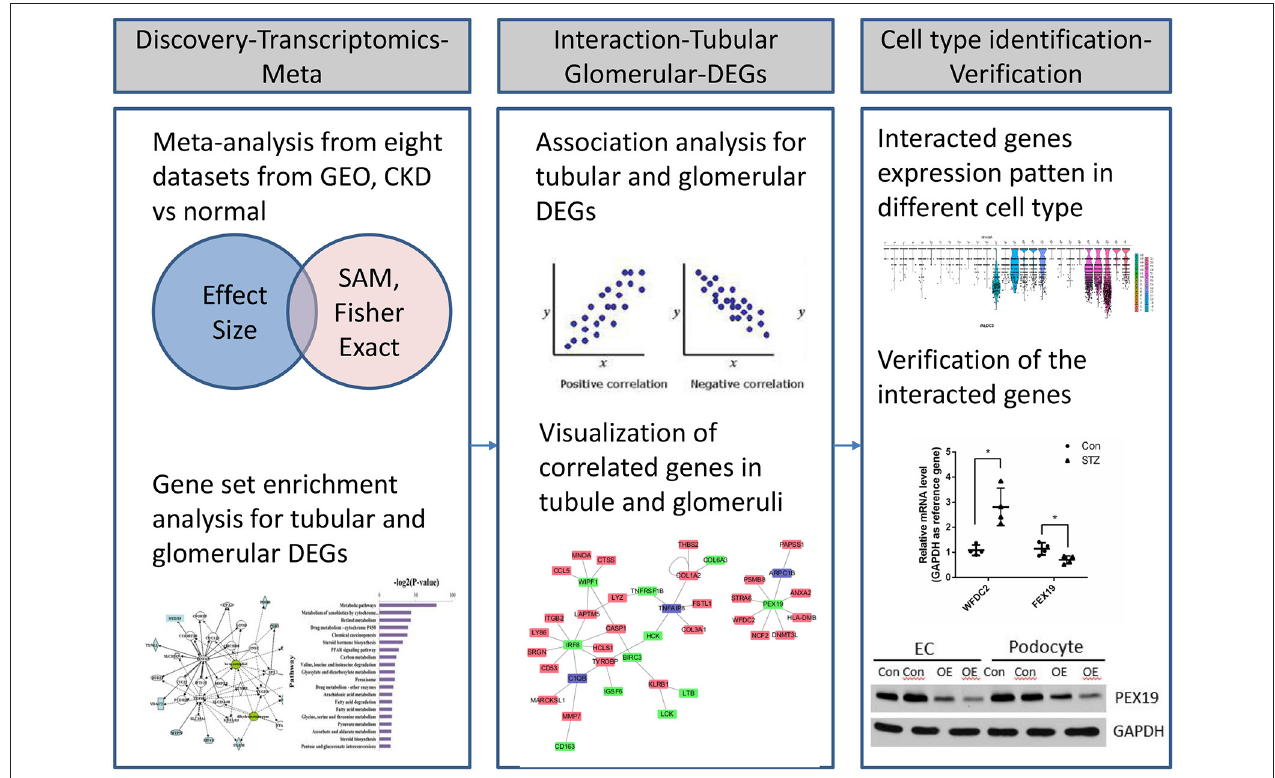
FIGURE 1 | Workflow of transcriptional profiling and identification of interacted genes through integrative informatics approach.